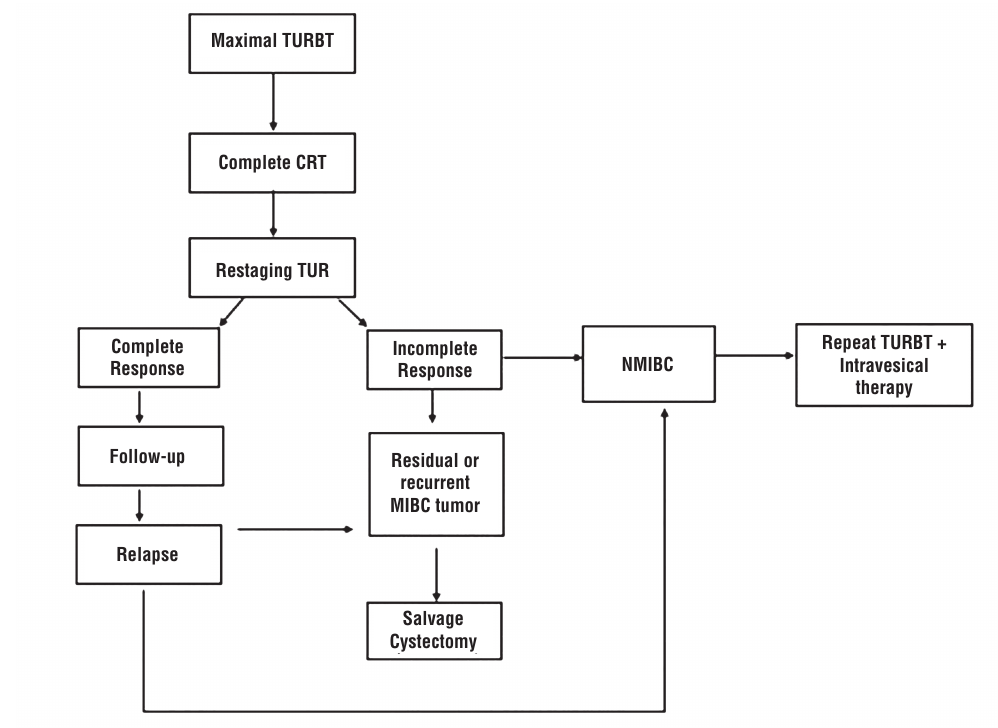
Figure 1 - Trimodal therapy treatment algorithm used at our institution, demonstrating an approach for continuous CRT and